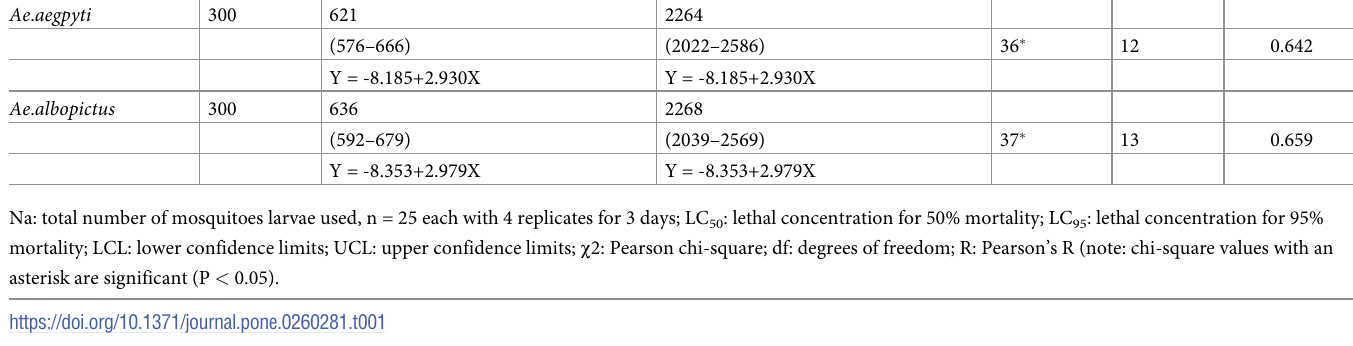
Table 1. Larvicidal activity of A . catechu extracts against early 4th instar larvae of Aedes aegypti and Aedes albopictus . Larvae Na